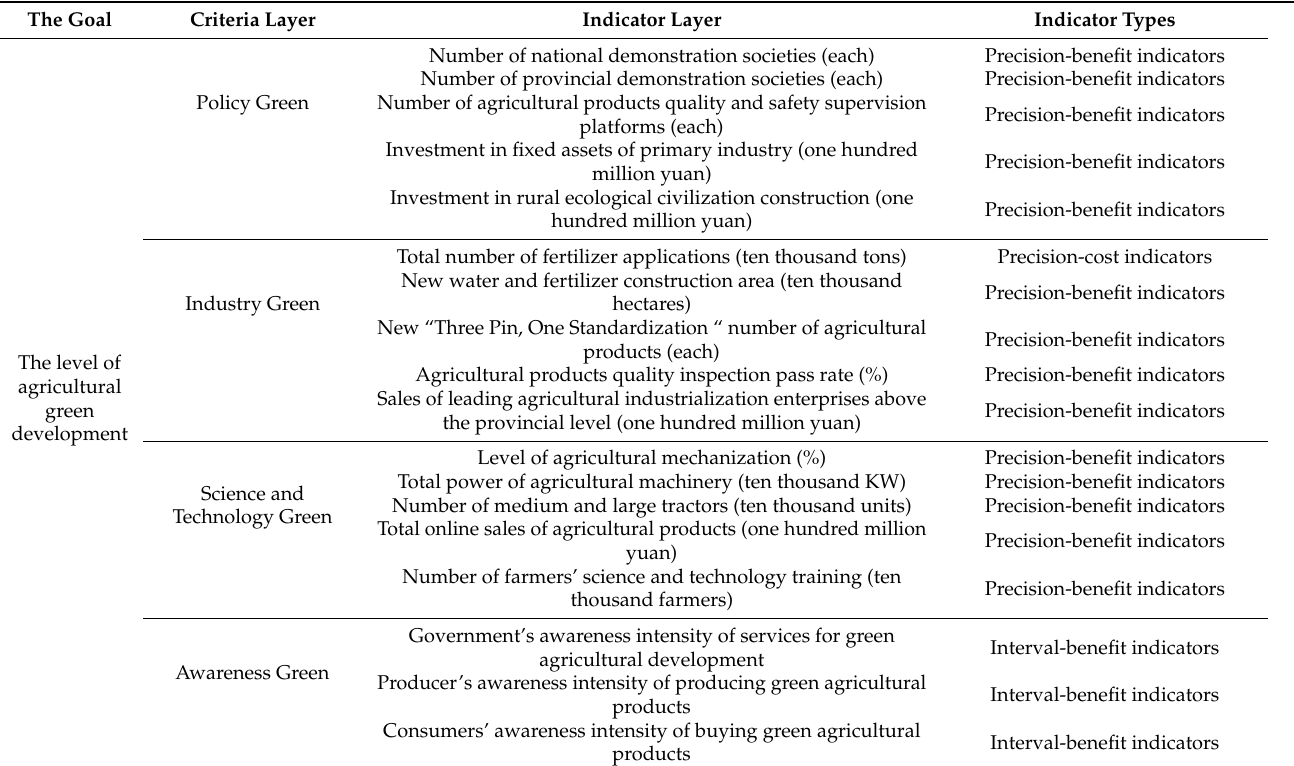
Table 1. Agricultural green development evaluation indicator